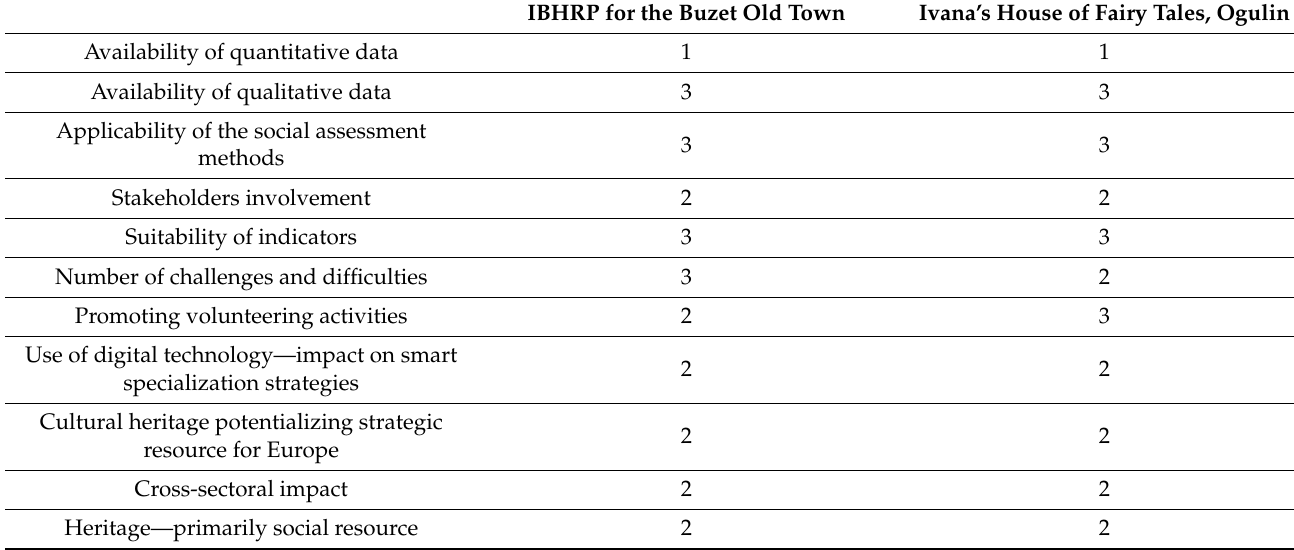
Table 2. The summary on challenging issues in cultural heritage evaluation. IBHRP for the Buzet Old Town Ivana’s House of Fairy Tales,